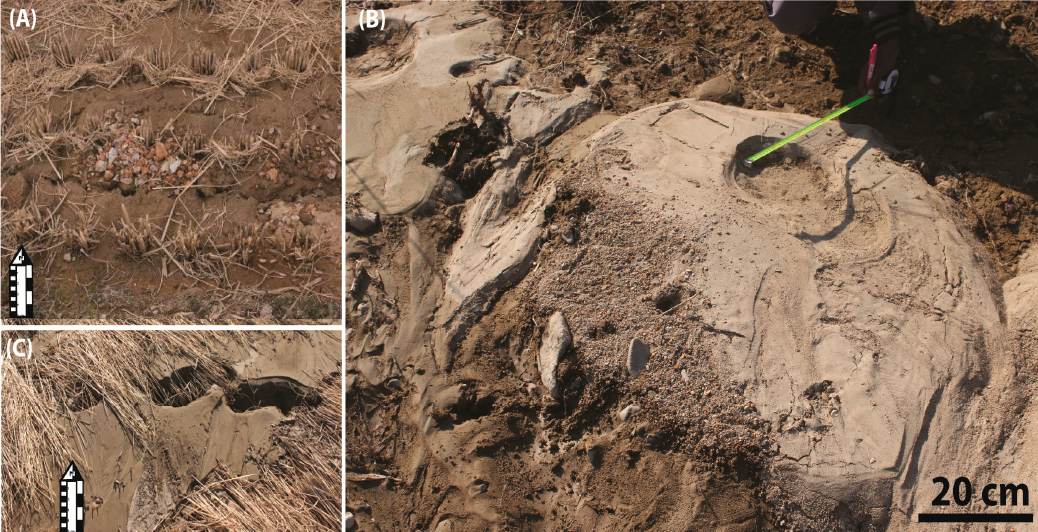
Figure 9. Field photos showing evidences of the gravelly soil liquefaction. ( A ) Photographs showing ejected gravels due to liquefaction through ground cracks; ( B ) sand boil showing evidence of gravelly soil liquefaction along a dry river bed; ( C ) sand boil showing ejected pebbles with fine sand in rice farm during the earthquake.